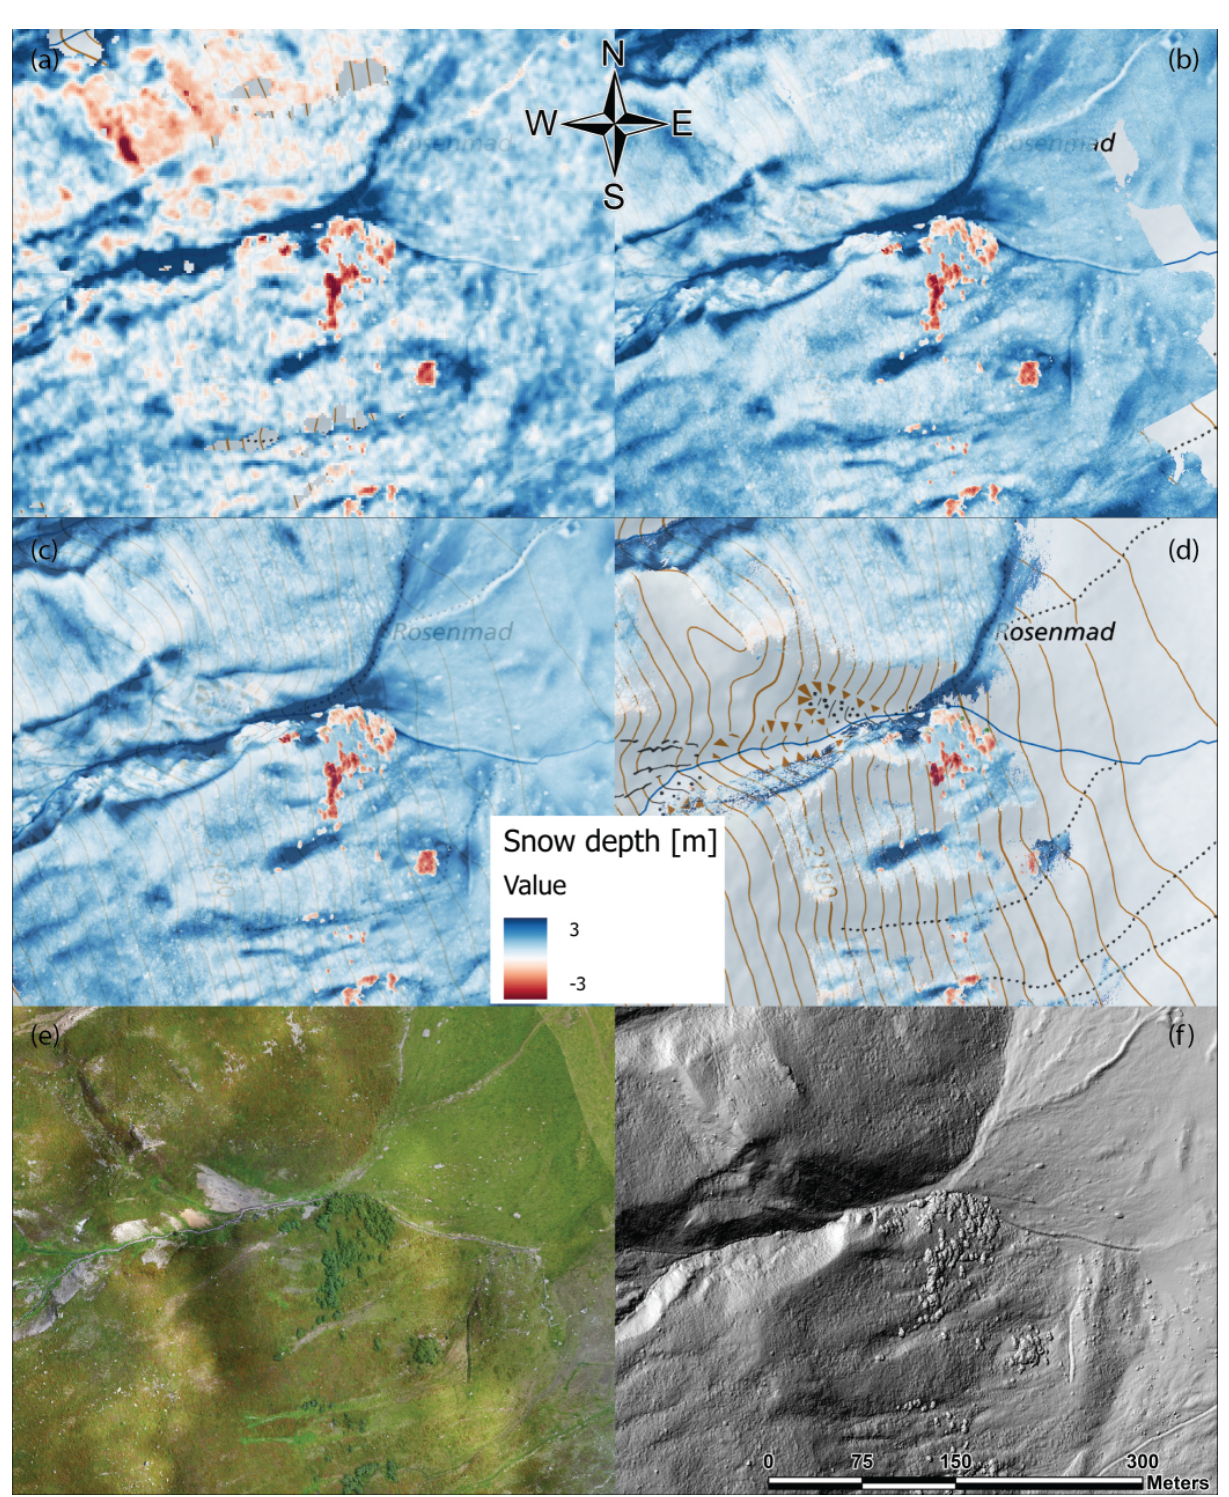
Figure 6. Inset of the Schürlialp snow depth maps shown in Fig. 5, with the scale ranging from − 3 to 3m to illustrate the negative snow depths caused by the vegetation. The effect of bushes (species Alnus alnobetula ) under compression by the snow is visible as the greatest negative snow depth values (dark red) in (a) satellite, (b) airplane, (c) UAS and (d) terrestrial snow depth map draped over the swisstopo basemap. An orthoimage for the same extent is shown in (e) from the UAS summer flight and shows a hillshade of the summer ALS scan. Positive snow depth values reach up to 5m in the gulley features in the study site (Swiss Map Raster, source: Federal Office of Topography; Pléiades data © CNES 2018, Distribution Airbus